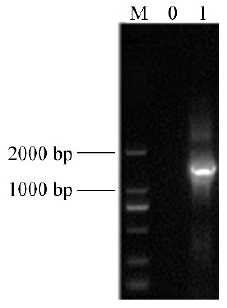
Figure 2. Agarose gel electrophoresis of the 16S r DNA-PCR products from the strain. Note: M, 2000 bp DNA ladder; 0, negative control group; 1, strain.